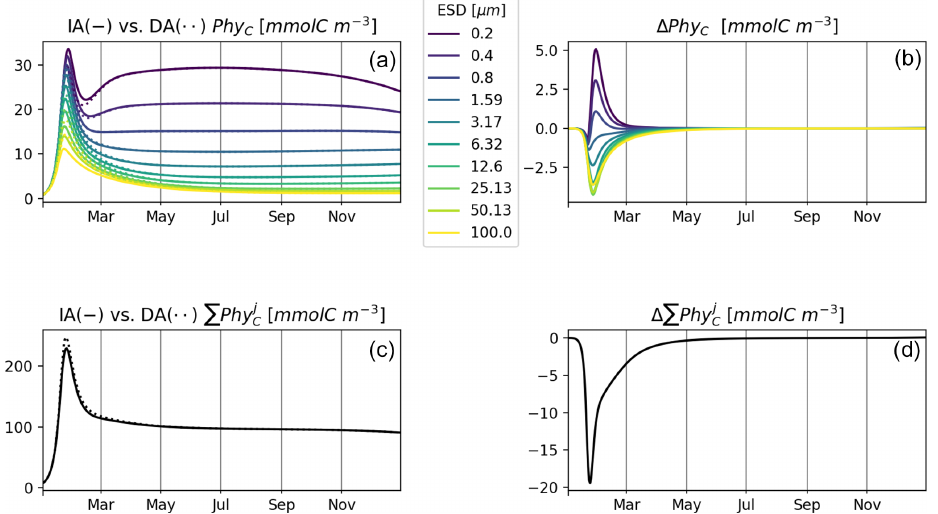
Figure 6. T3: (a, b) C biomass of 10 phytoplankton size classes in the IA (solid line) and DA (dotted line) variants (a, c) and the difference between IA and DA (b, d) . (c, d) Sums of phytoplankton C biomass simulated by the IA and DA variants (a, c) and their differences (b, d) .